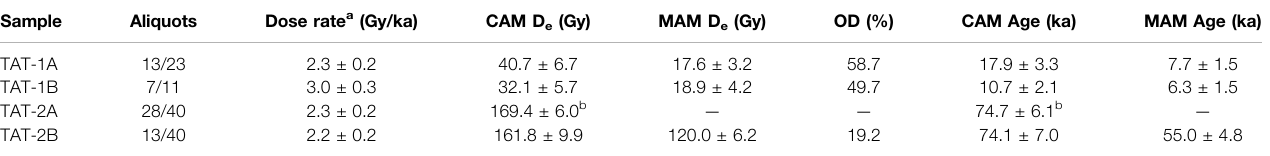
TABLE 2 | Results of optically stimulated luminescence dating.